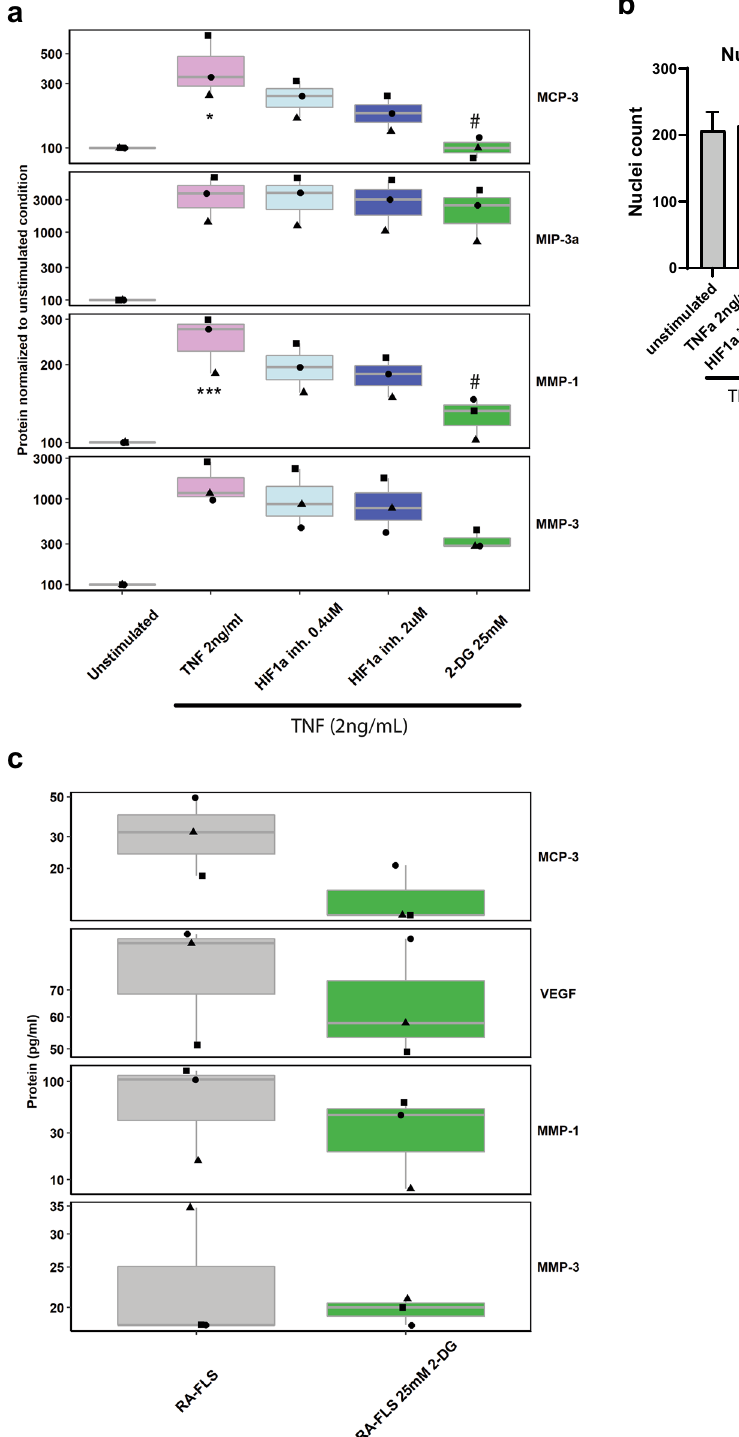
Figure 5. Inhibition of glycolysis reduces biomarker secretion in FLS. ( a - b ) Fibroblast-like synoviocytes from three healthy donors were stimulated with recombinant human TNF (2 ng/ml) and the HIF1A inhibitor HIF V or 2-deoxyglucose, a competitive inhibitor of hexokinase for 24 h in the indicated concentrations. ( a ) Luminex®Multiplex assay to evaluate cytokines and disease-relevant biomarkers in cell culture supernatants (n = 3 different donors, experiments were performed in 3 technical replicates). One-way ANOVA with Tukey multiple pairwise-comparisons. Data are shown as boxplot with median and first and third quartile. Donors are highlighted with different shapes. ***P ˂ 0.001 vs. unstimulated control, #P<0.05 vs. TNF stimulation. ( b ) Nuclei number ( c ) Fibroblast-like synoviocytes from three RA patients were treated with 24 mM 2-deoxyglucose (2-DG), a competitive inhibitor of hexokinase (24 h). Luminex®Multiplex assay to evaluate cytokines and disease-relevant biomarkers in cell culture supernatants (n = 3 different donors, experiments were performed in 3 technical replicates). One-way ANOVA with Tukey multiple pairwise-comparisons. Data are shown as boxplot with median and first and third quartile. Donors are highlighted with different